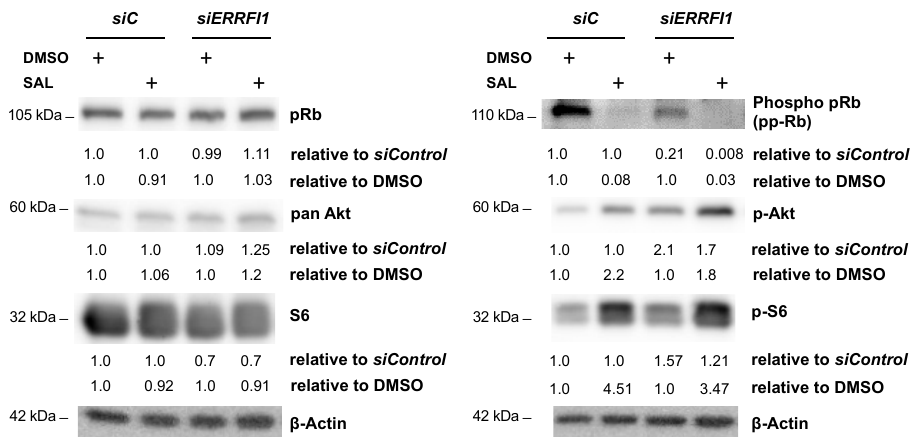
Figure 6. siRNA mediated knockdown of ERRFI1 decreases phospho-p-Rb (pp-Rb) and enhances p-AKT and p-S6 levels. siERRFI1 knockdown LNCaP cells treated for 72 h were analyzed for changes in pRb, AKT and S6 levels using Western blotting. siControl ( siC ) served as transfection control. Upper numbers indicate the fold-change of protein level relative to the particular treatment in transfected control cells. Lower numbers indicate a fold-change of protein levels relative to solvent control DMSO.